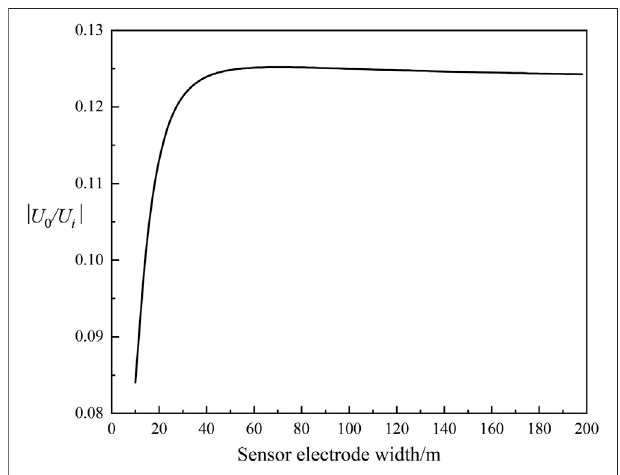
FIGURE 7 | Variation curve of transfer function amplitude with electrode